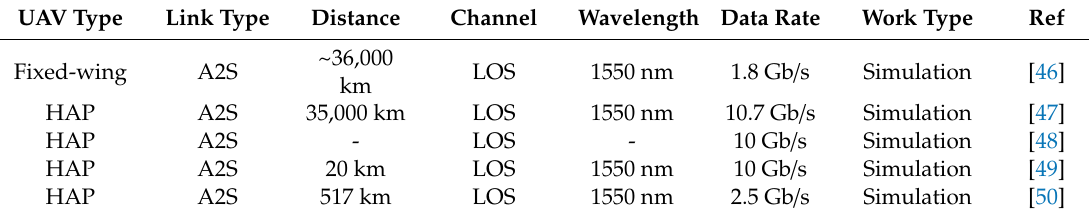
Figure 3. Illustration of the optical uplink, optical downlink, and the Doppler e ff ects between UAV. Table 2. Research on A2S experiment